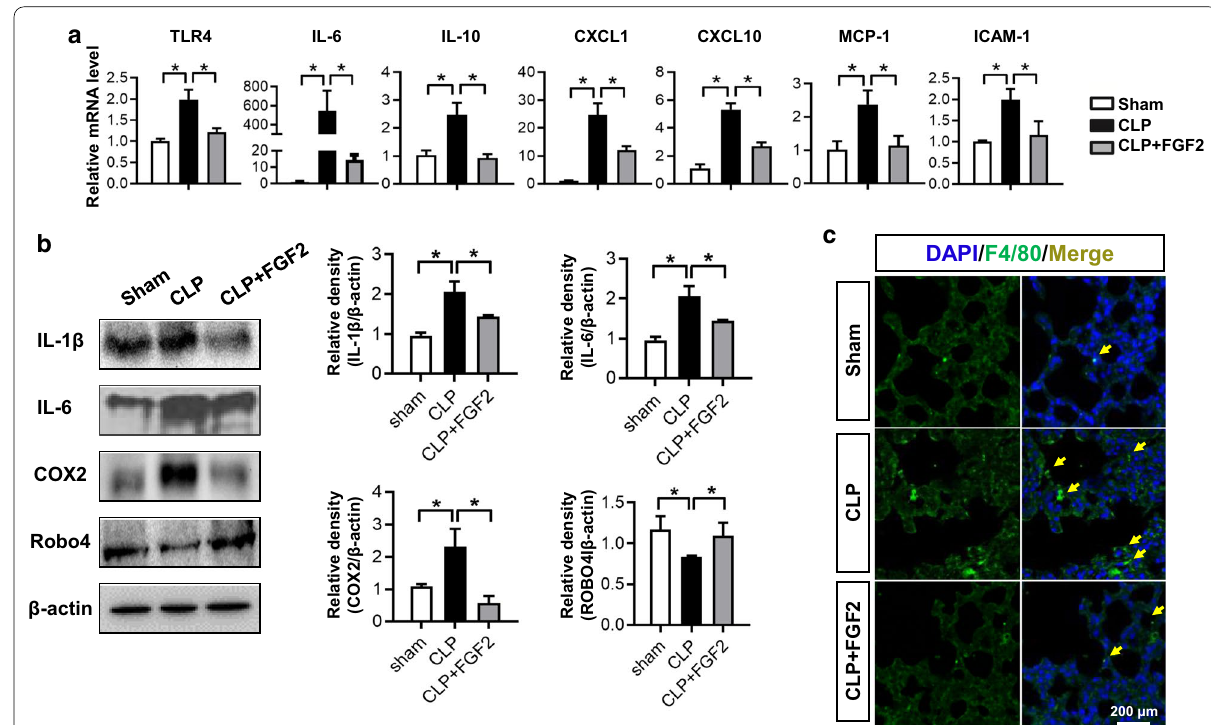
Fig. 3 FGF2 reduced the inflammatory response in ALI. a Relative lung gene expressions of TLR4, IL-6, IL-10, CXCL1, CXCL10, MCP-1 and ICAM-1 were measured by quantitative real-time RT-PCR (n 5 per group, relative to GAPDH). b The IL-1β, IL-6, COX2, Robo4 and β-actin protein levels in ≥ the lung tissues 24 h after the surgery by western blot and the quantification of protein expressions were shown (n represented as mean SEM. c The F4/80 on behalf of macrophage of lung tissue sections was stained by immunofluorescence. The sections are all ± shown at 400 magnification. *P < ×